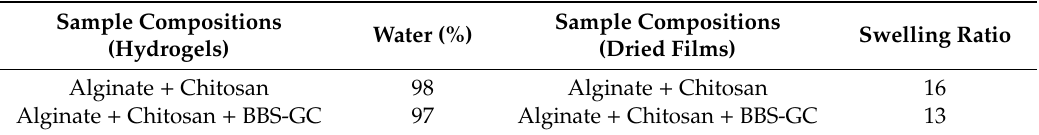
Figure 3. ( A ) Thermal gravimetrical analysis (TGA) and ( A1 ) Di ff erential thermal analysis (DTA) profiles of BBS-GC (black curve), sodium alginate (red curve), chitosan (blue curve), F-Alg / Chito (green curve) and F-Alg / Chito / BBS (magenta curve); ( B ) TGA profiles for hydrogels: H-Alg / Chito / BBS (solid curve) and H-Alg / Chito (dashed curve). Table 1. Hydrogels water content (wt.%) evaluated using TGA and swelling ratio values found by water uptake experiments on dried